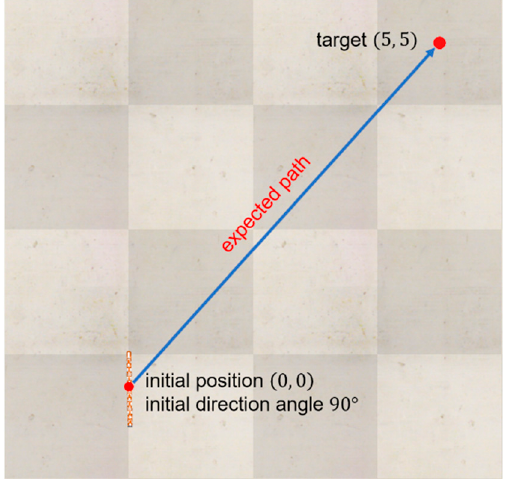
Figure 11. The initial state of the snake robot.